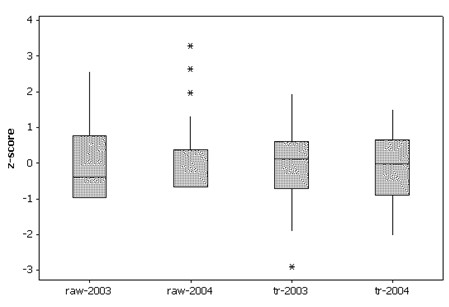
Boxplots of raw and transformed percentage deaths from diagnosed WNV cases.